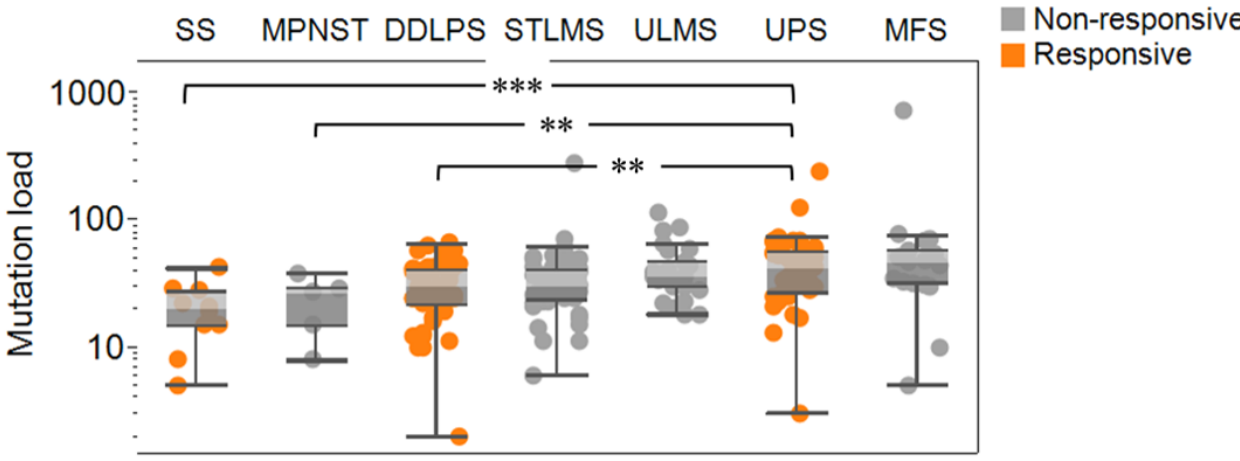
Figure 1. Mutational load (the number of coding mutations) in soft tissue sarcoma subtypes. Subtypes analyzed include synovial sarcoma (SS), malignant peripheral nerve sheath tumor (MPNST), dedifferentiated liposarcoma (DDLPS), soft tissue leiomyosarcoma (STLMS), uterine leiomyosarcoma (ULMS), undifferentiated pleomorphic sarcoma (UPS), and myxofibrosarcoma (MFS). Subtypes are sorted by median mutation load. Orange color indicates subtypes that responded to immunotherapy in SARC028. ** indicates p < 0.01, *** indicates p <